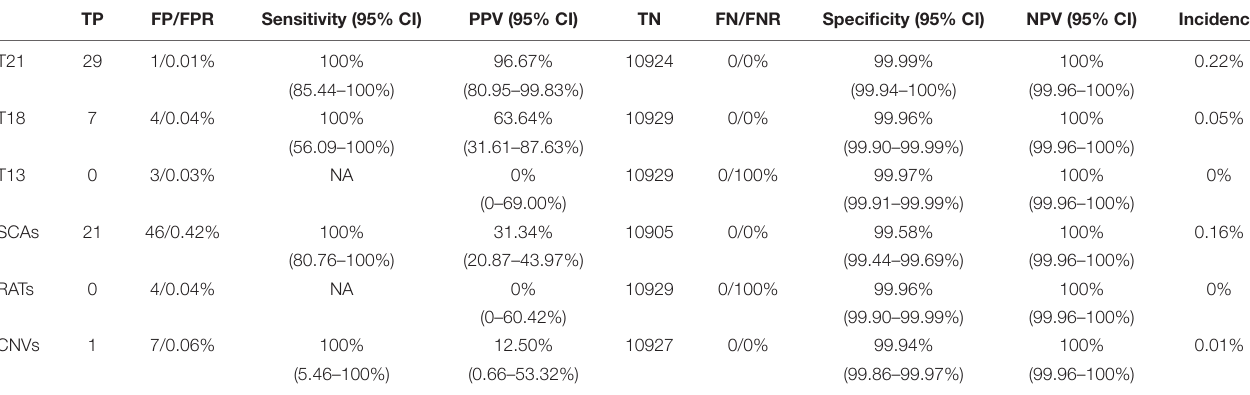
FIGURE 2 | Detailed outcome of NIPT negative results. TOP, termination of pregnancy. TABLE 4 | Performance of NIPT in detecting trisomies 21, 18, 13, SCAs, RATs, and